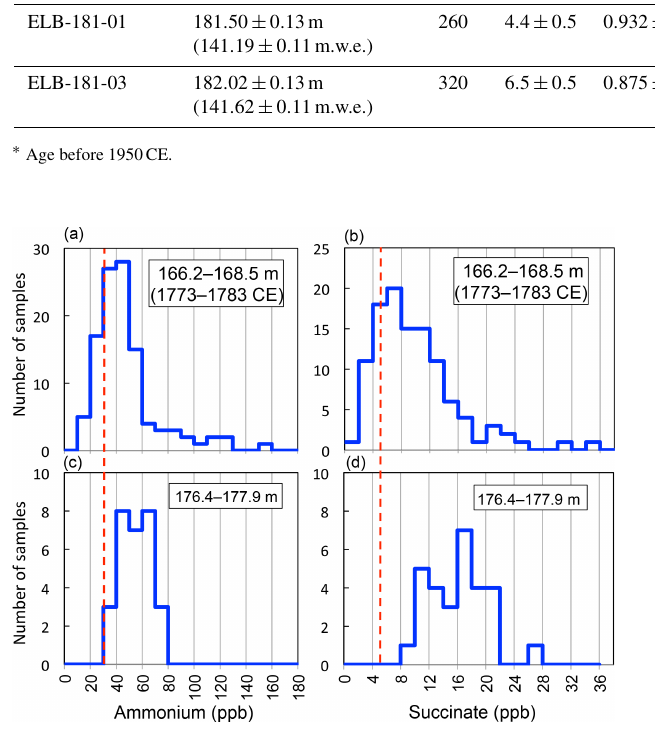
Figure 4. Distribution of succinate and ammonium concentrations observed in the deepest ice layers for which annual counting was possible (i.e. above 168.5m depth, a, b ) and 10m below (c, d) . The vertical red dashed bars denote the values of the winter